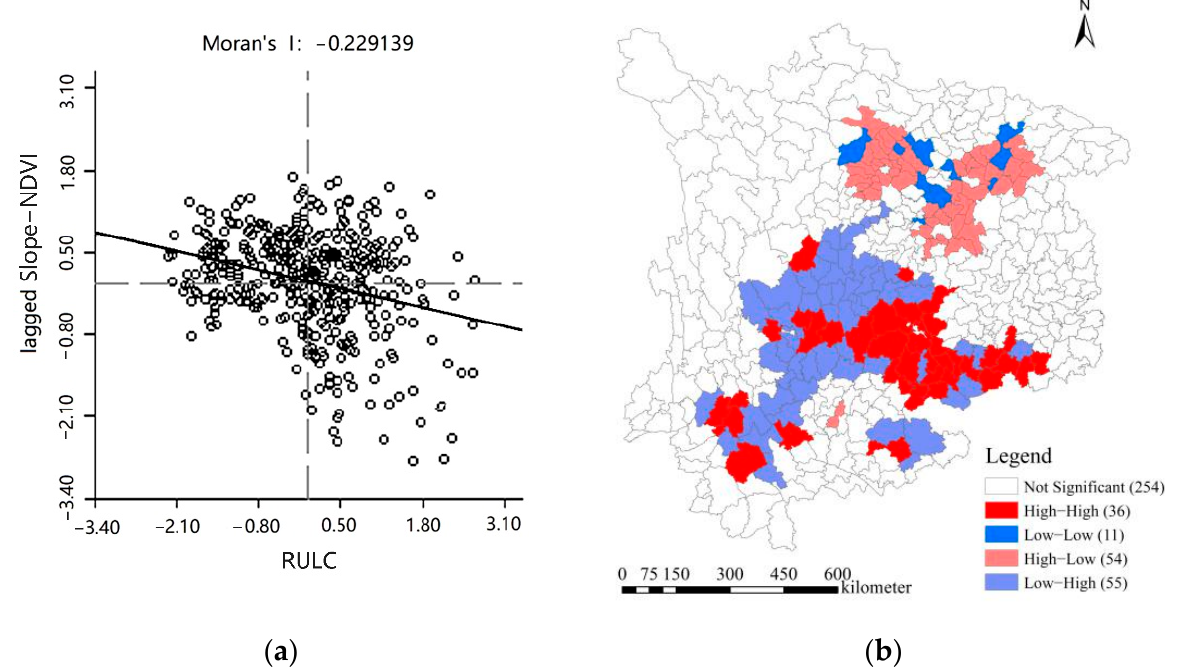
Figure 6. Results of spatial autocorrelation between the RULC and the Slope − NDVI. ( a ) Moran’s I Scatter plot. ( b ) Local agglomeration map.